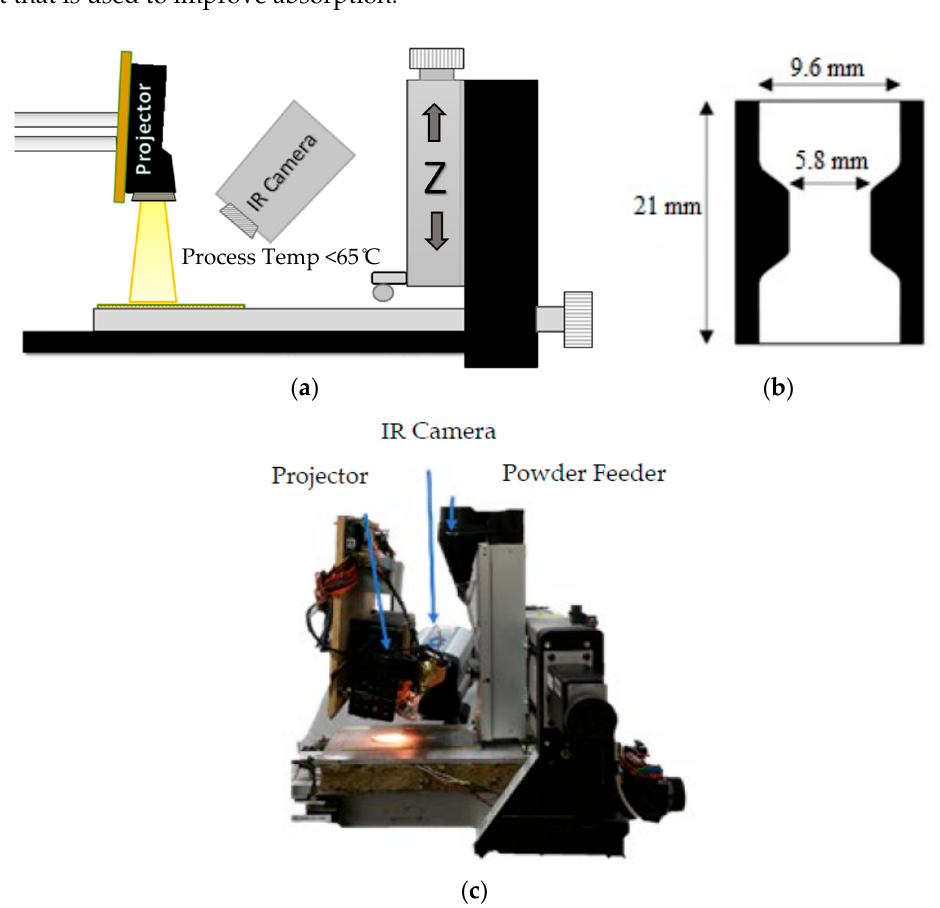
Figure 2. ( a ) Diagram of the set up used to simulate the large area projection sintering (LAPS) additive manufacturing process. ( b ) The image projected onto the powder mixture to fabricate each sample. ( c ) A photograph of the hardware.